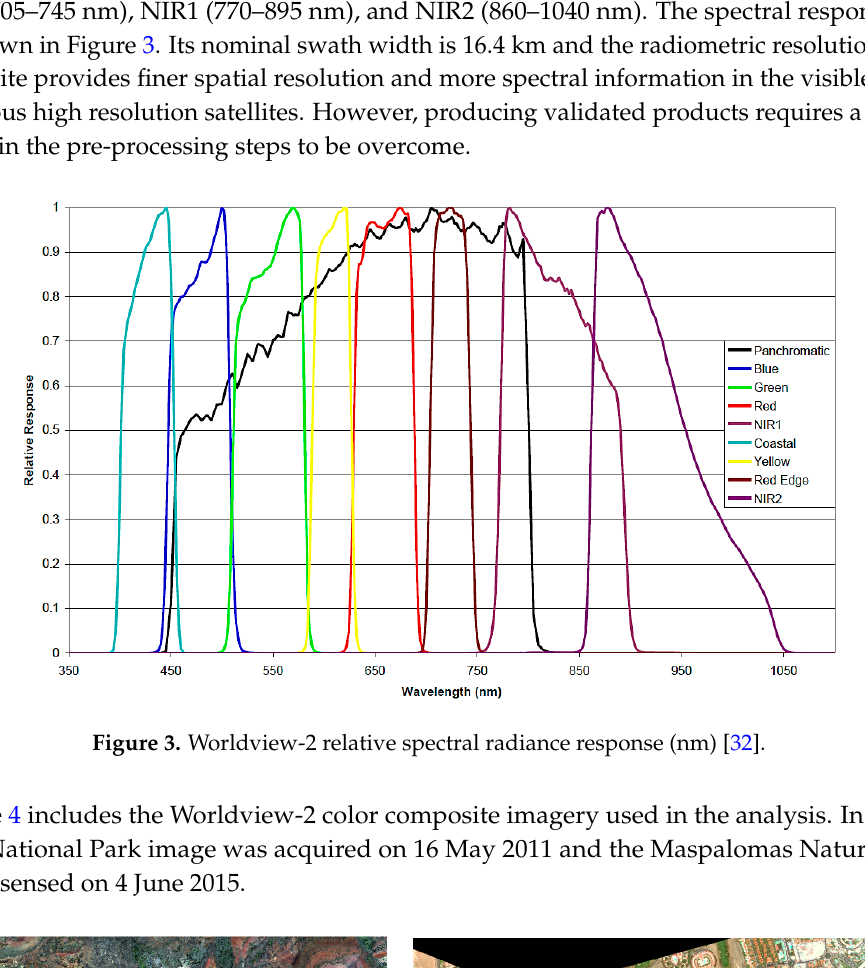
Figure 2. Vegetation measured at the Teide Park: ( a ) Spartocytisus supranubius ; ( b ) Pterophalus